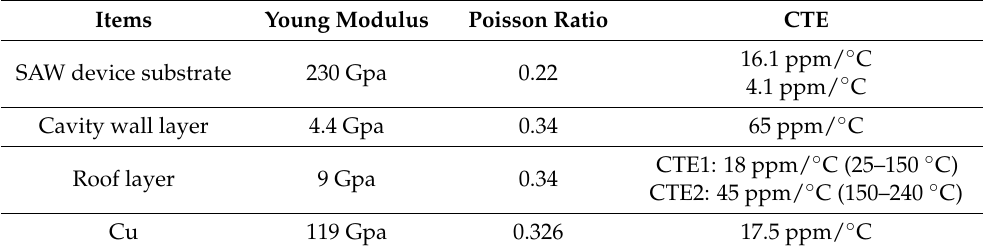
Figure 6. The single-die FE modeling. Table 1. Material properties of the two single-die models. Table 1. Material properties of the two single-die models.